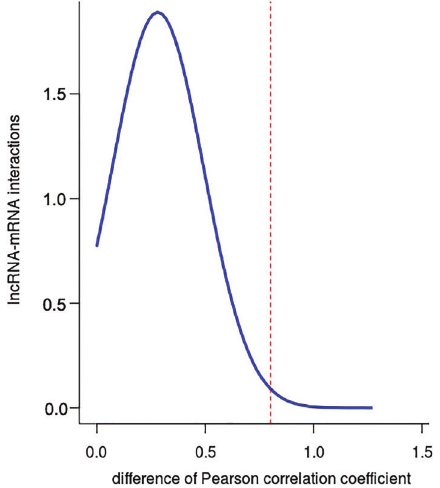
Figure 1. Weight distribution of 18,939 competitive endogenous RNAs (ceRNA)